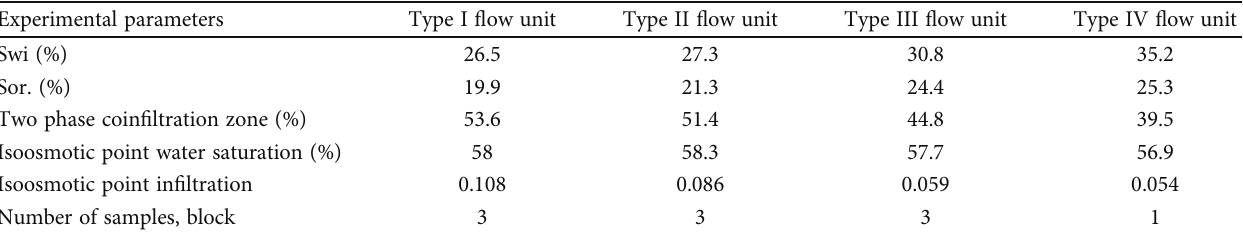
Table 1: Statistics of phase permeability parameters of di ff erent types of fl ow units.